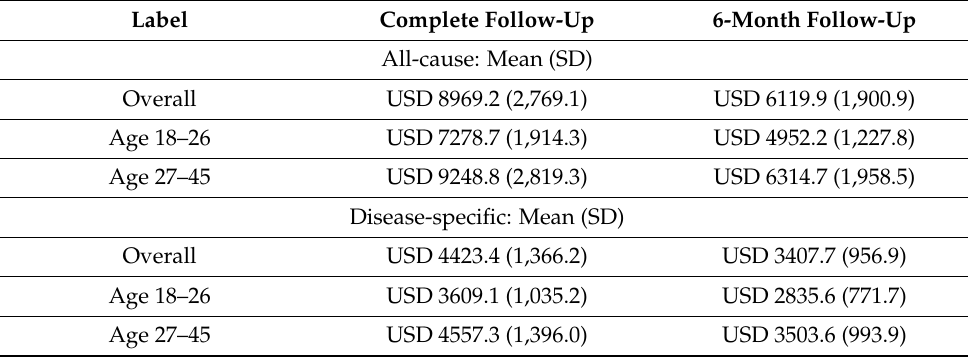
Table 2. All-cause and disease-specific adjusted total costs based on GLM